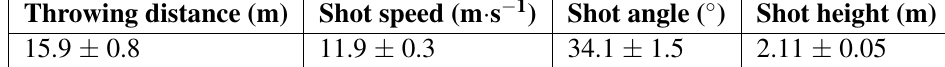
Table 2 List of athletes throwing data.